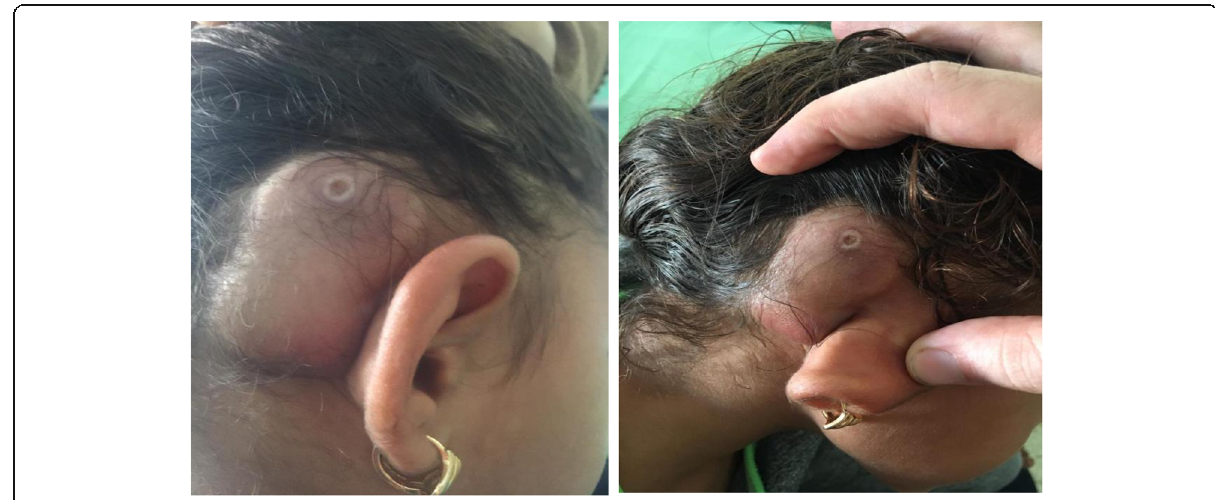
Fig. 4 Device migration after